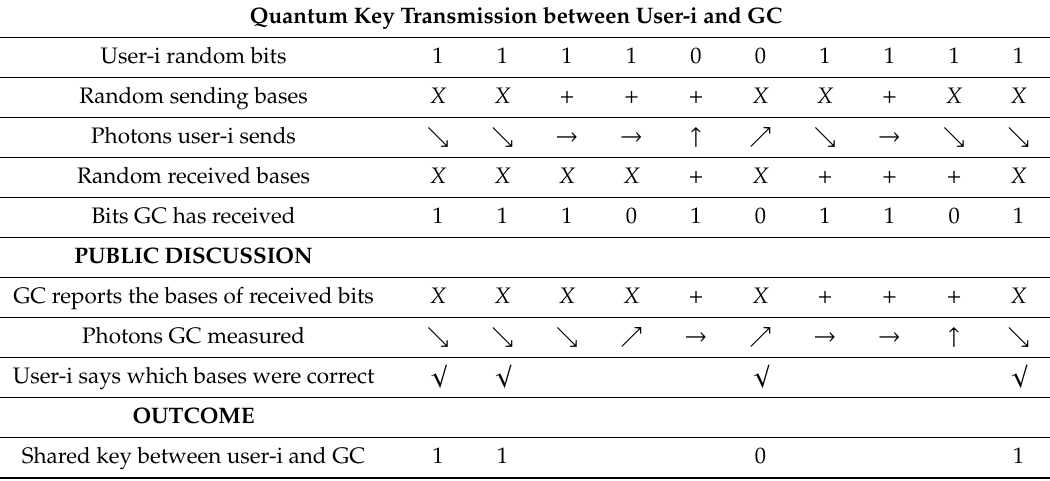
Table 4. Shared key calculated by all the other group users except GC. Quantum Key Transmission between User-i and